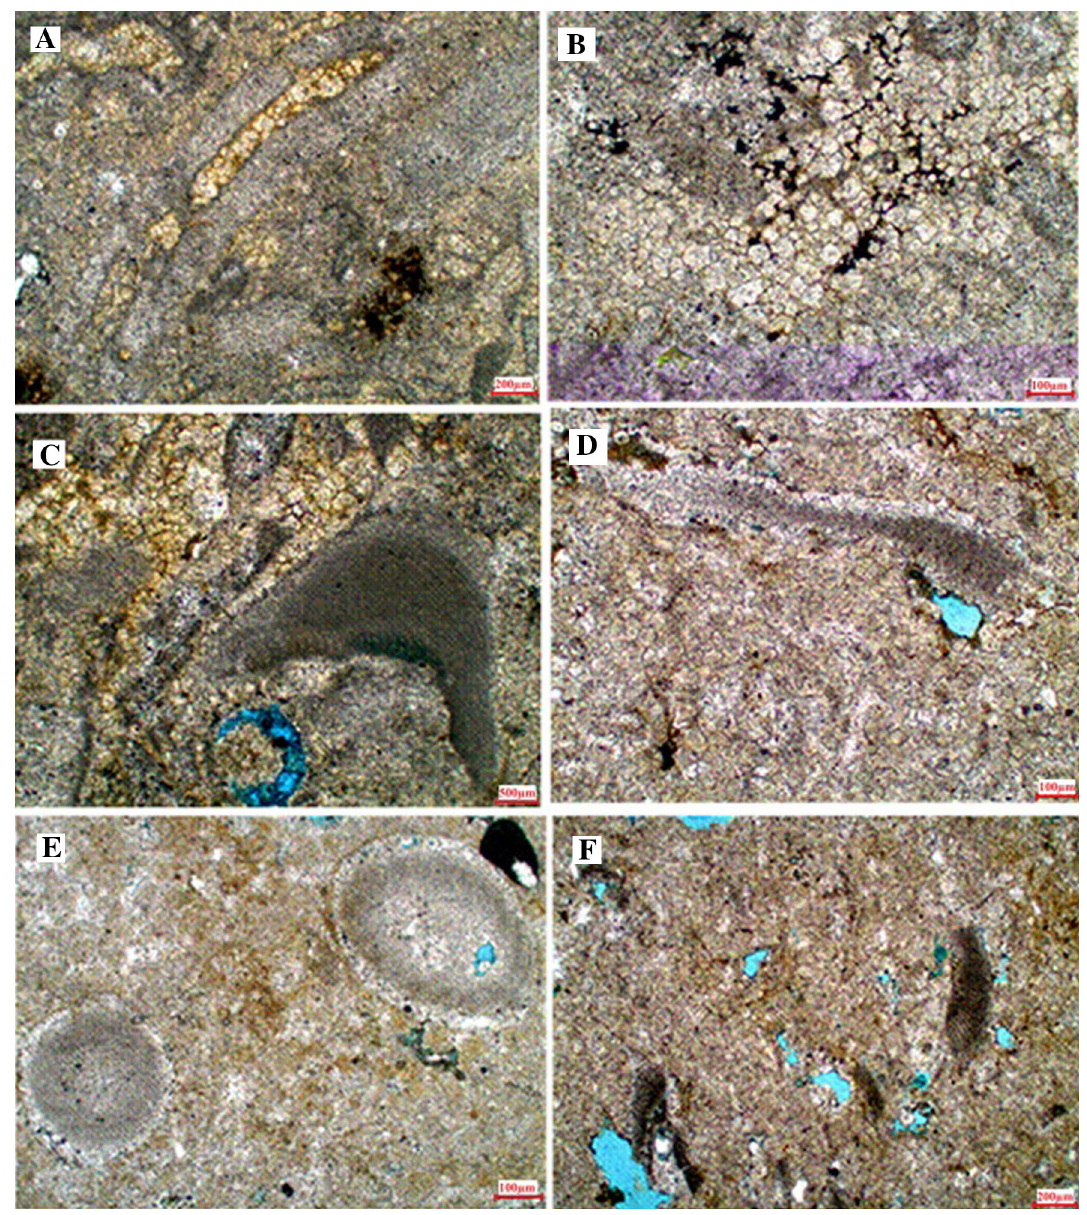
Fig. 8 a showing very fine crystalline planar-e to planar-s zoned dolomite with ‘‘ghost’’ of early replaced shell fragments texture. b showing very fine crystalline planar-e zoned dolomite with ferruginous cement. c , d showing very fine crystalline planar-e to planar-s zoned dolomite with red algae and ghosts of ooids, in c Red